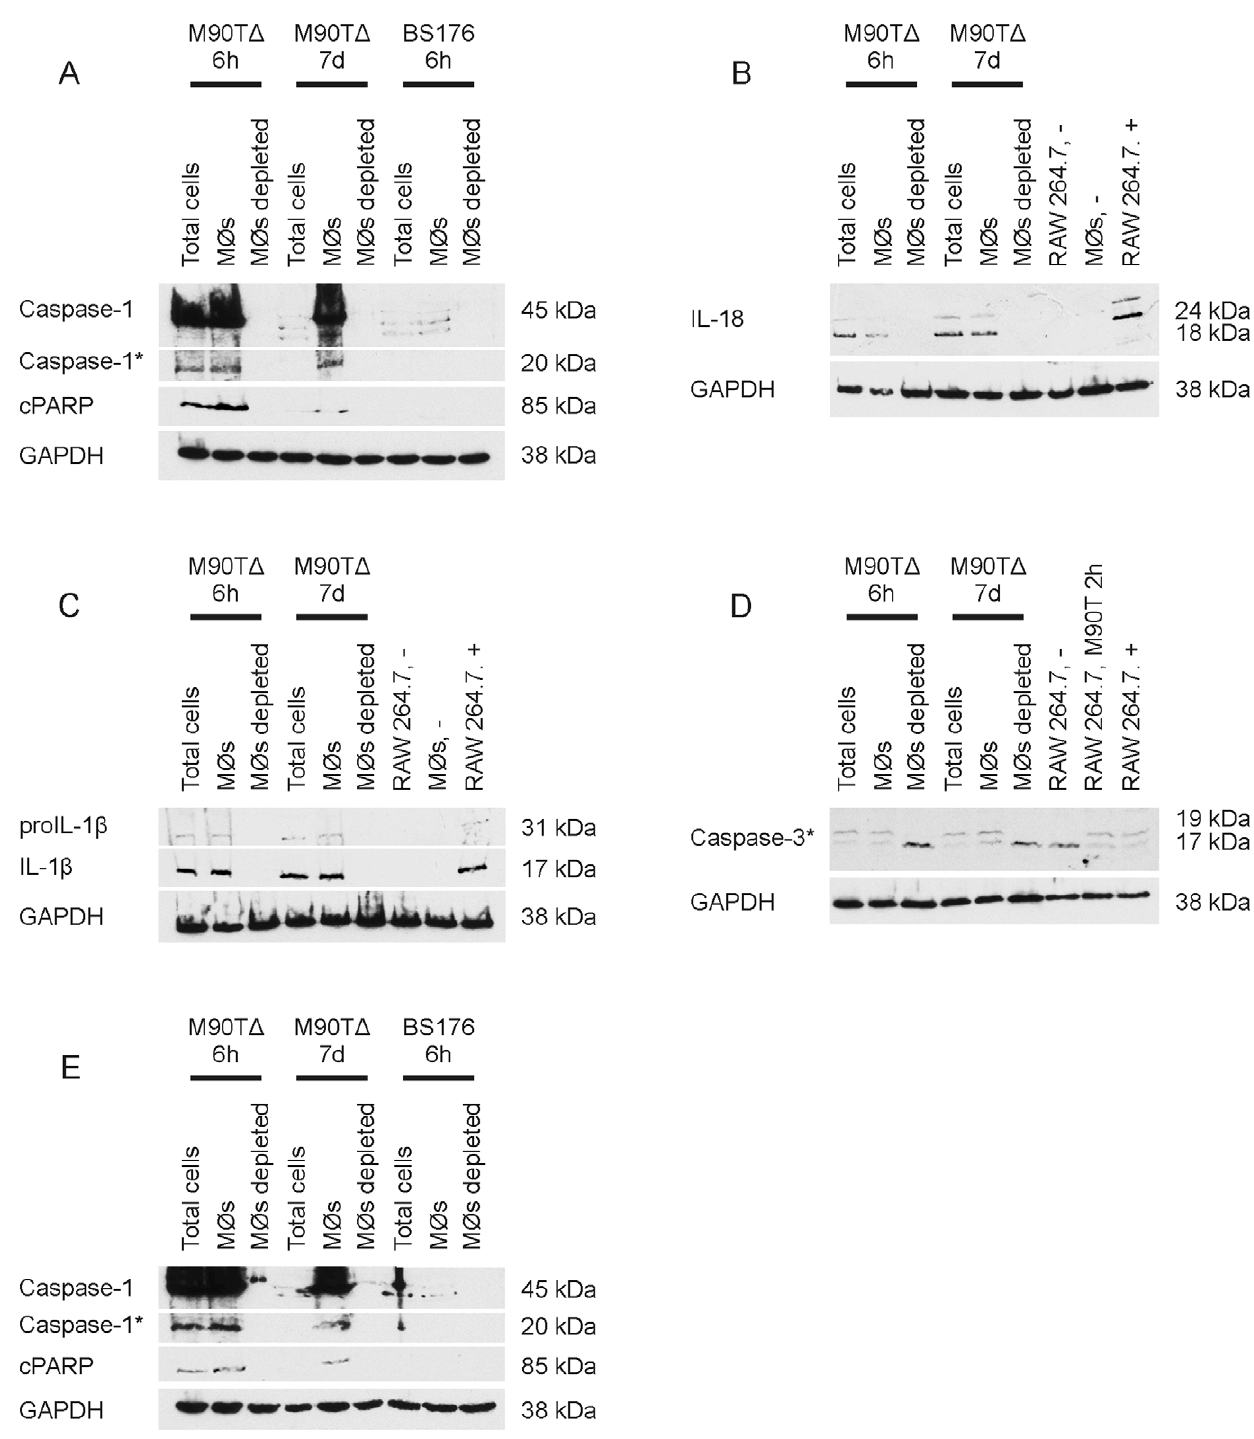
Figure 3. Infection of tumor-bearing mice with Shigellaflexneri M90T D aroA , but not S.flexneri BS176 D aroA induced consistent caspase-1 processing and apoptosis in TAMs in vivo. Western Blot analysis for caspase-1 (A, E), IL-1 b (C), IL-18 (B), caspase-3 (D) processing and PARP cleavage (A,E) in Balb/c (A–D) and transgenic MMTV-HER2 (E) mice. BS176 D : Shigella flexneri BS176 D aroA ; M90T D : Shigella flexneri M90T D aroA